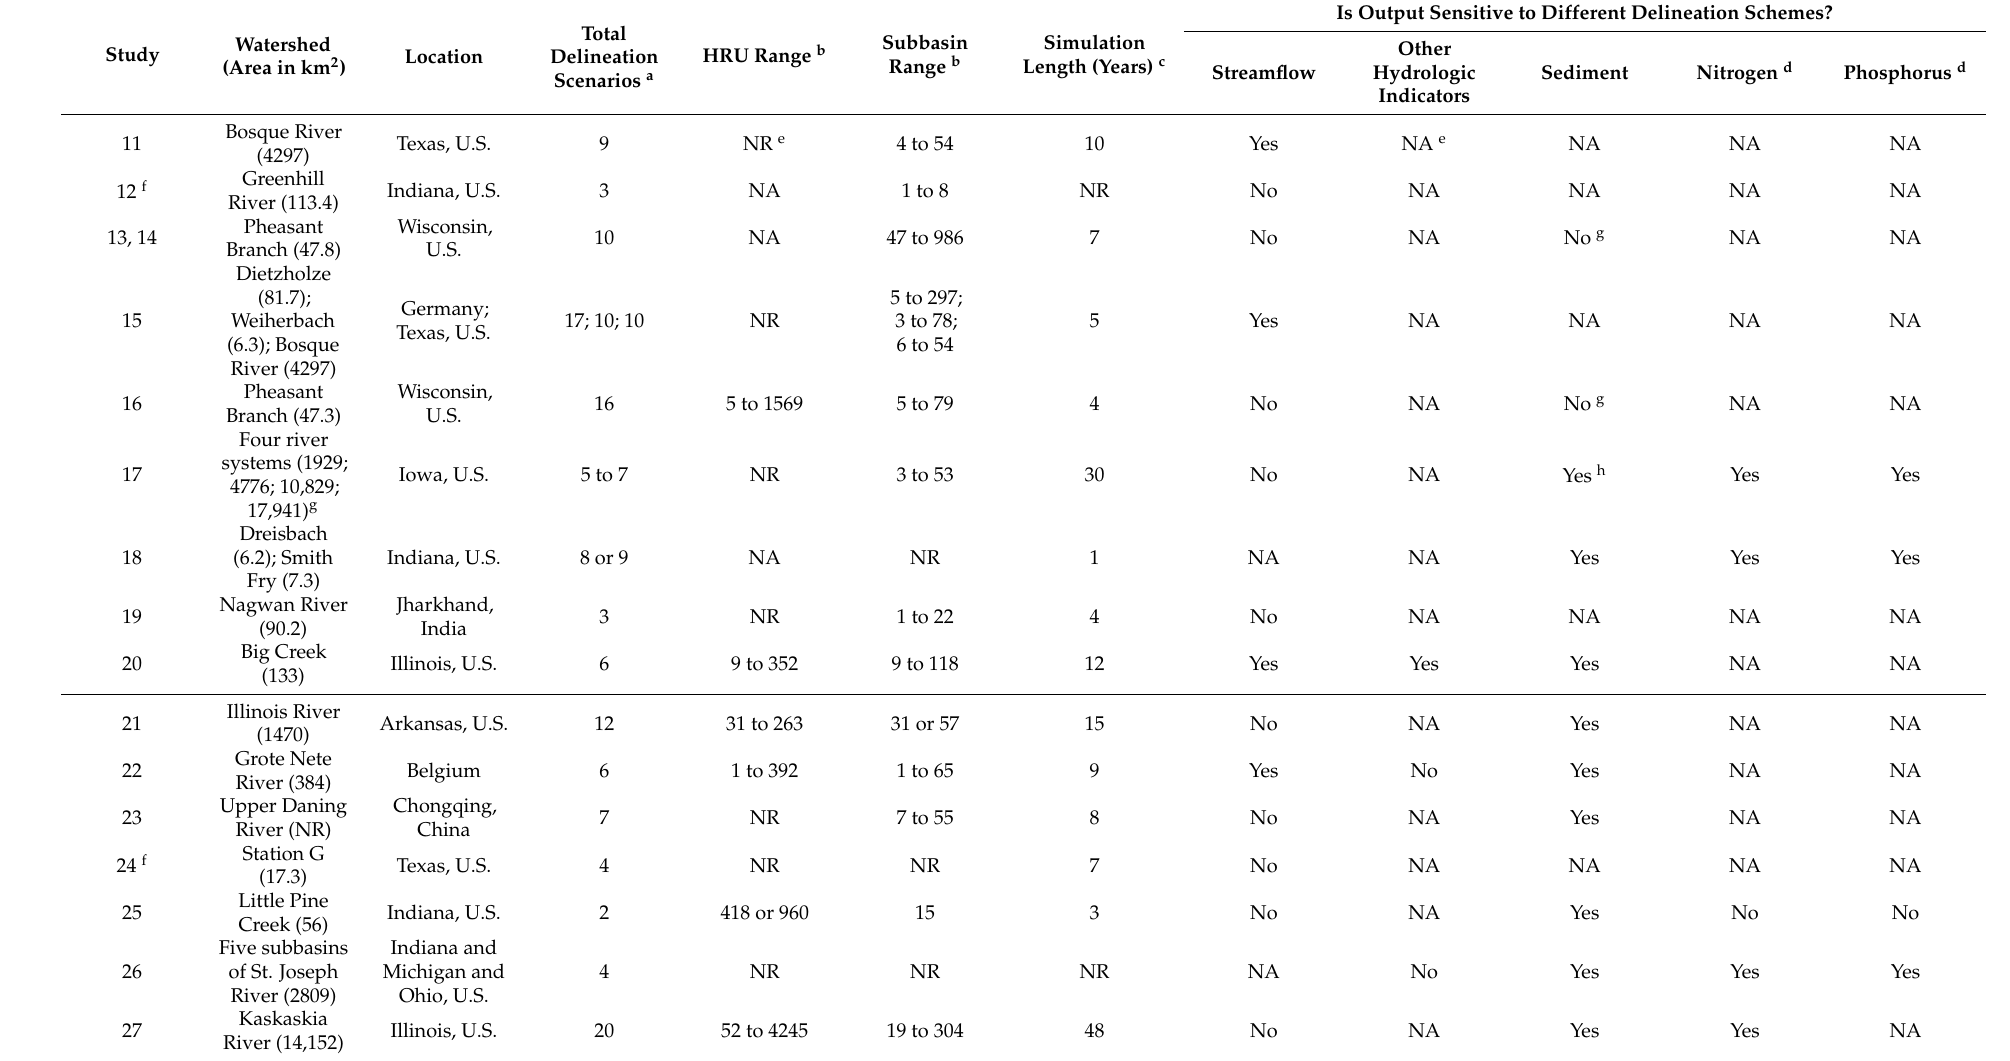
Table 1. Summary of previous SWAT studies that reported the effects of different HRU and/or subbasin delineations on SWAT